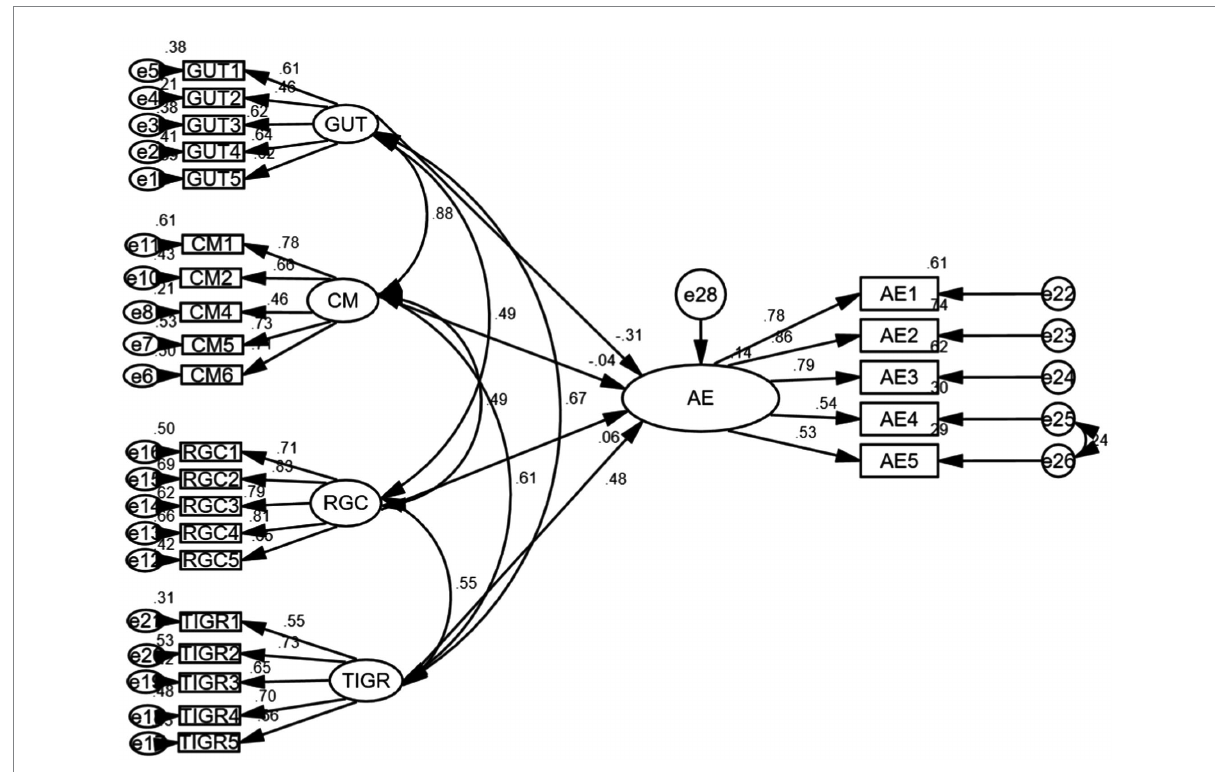
FIGURE 5 The path between digital nativity and adverse effects of Smartphone